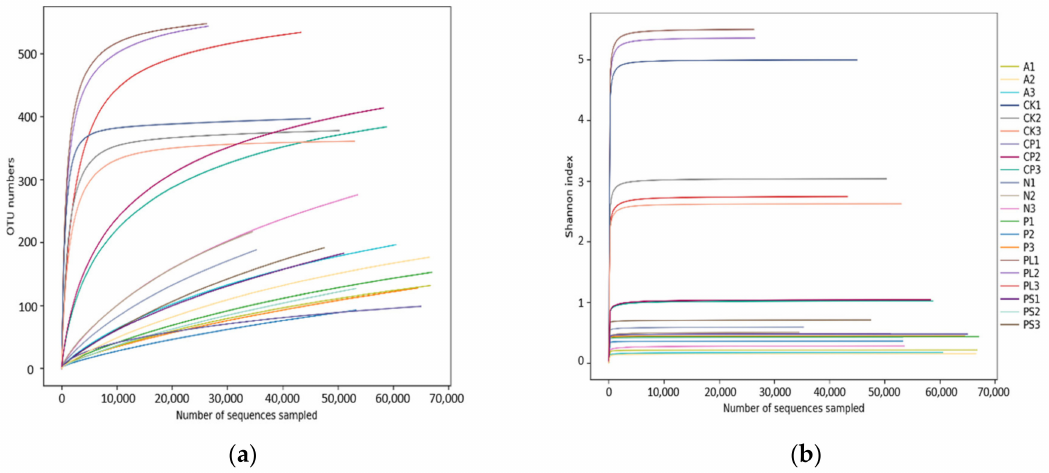
Figure 1. ( a ) Sample rarefaction curves and ( b ) the Shannon index rarefaction